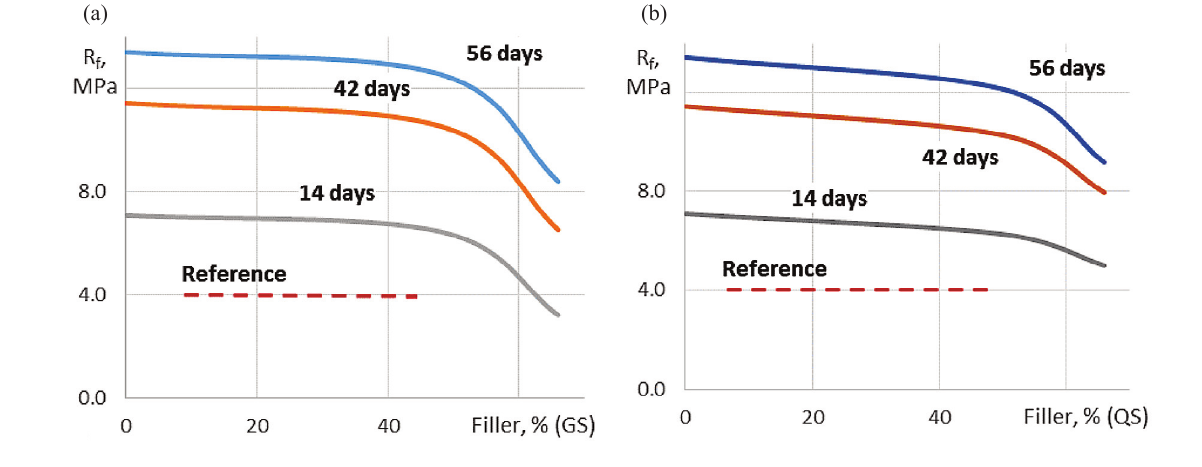
Fig. 6. Dependence of flexural strength on the amount of filler in the mixture: a – granite sand, b – quartz sand.